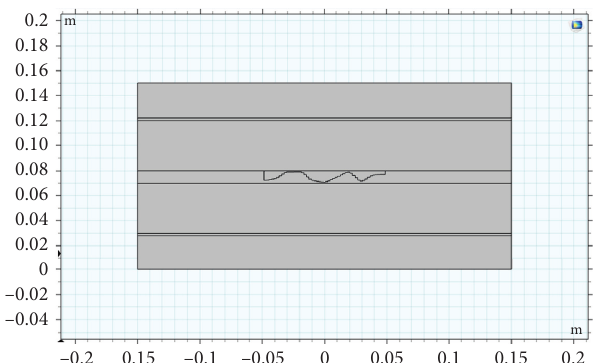
Figure 7: Dimension of the forward model with a defect of 49